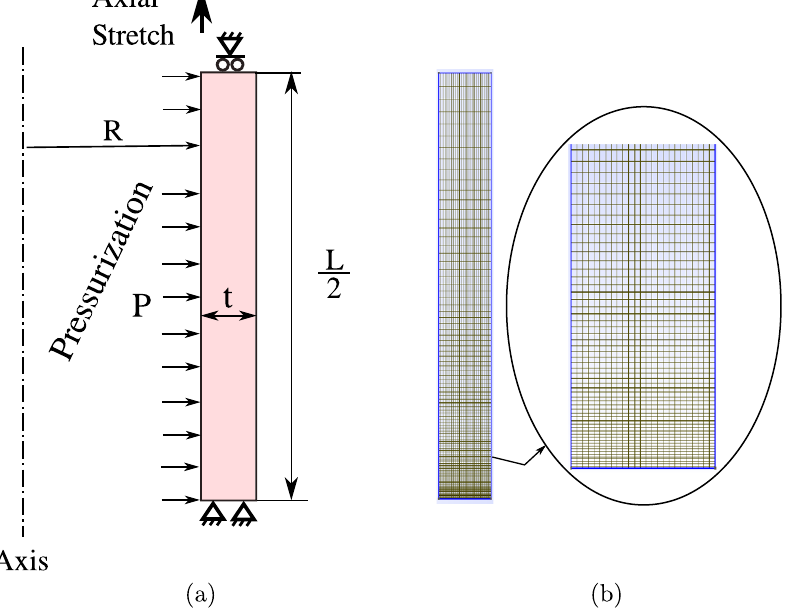
Figure 3. ( a ) Representation 2D of the boundary conditions for the computational simulation of the pressurization test. ( b ) View of the 2D finite element